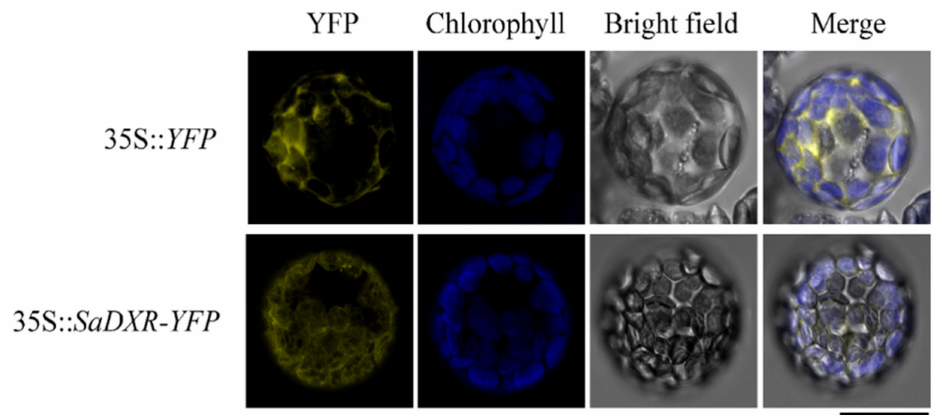
Figure 4. Subcellular localization of SaDXR. The signal was observed by a confocal laser scanning microscope. Transient expression of 35S:: YFP and 35S:: SaDXR-YFP in living protoplasts, displaying YFP fluorescence (yellow), chlorophyll autofluorescence (blue), bright field, and merged image (yellow plus blue). Bar: 20 µ